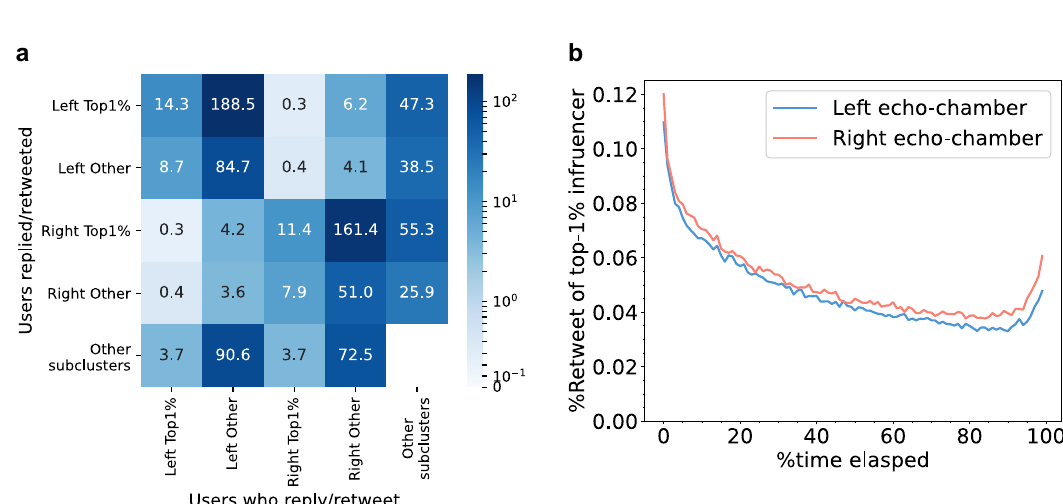
Figure 5. Word cloud 54 visualisation of top frequently tweeted words of each group of the core users in each EC: The top 50 exclusively frequent words in the influencer/co-reply/retweet core for both groups are listed. The words are limited to words tweeted more than 30 times per day in each set of top 100 users. Personal information and country or place names are concealed for privacy reasons.